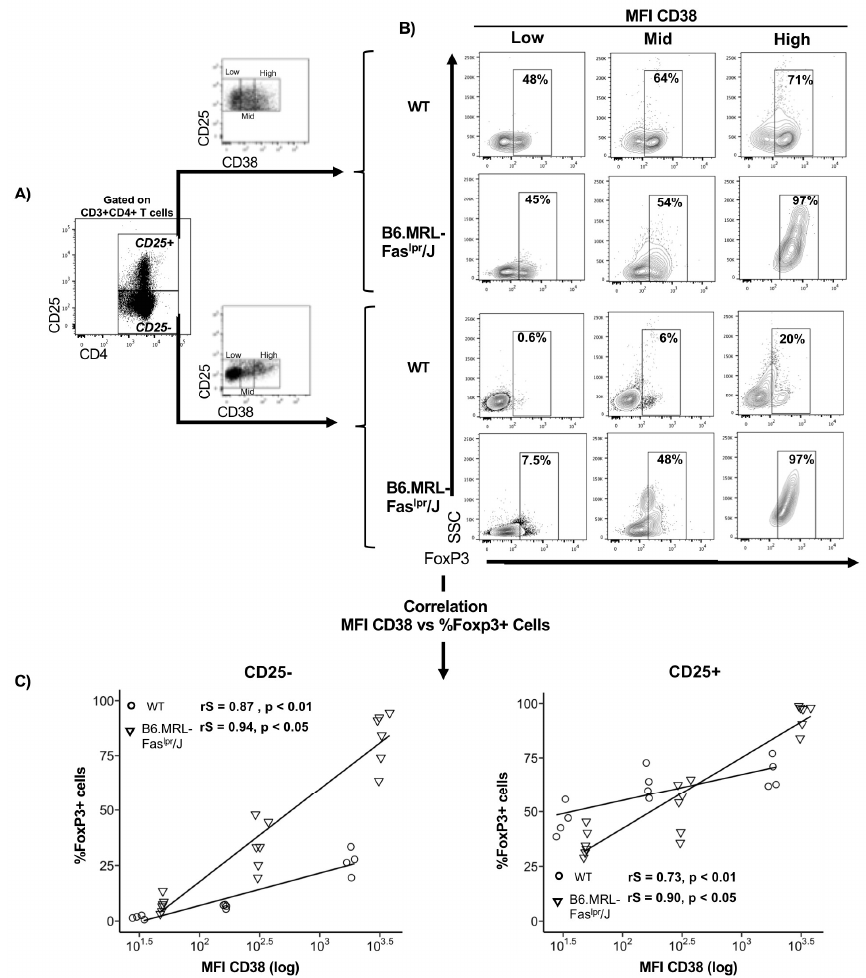
Figure 1. The level of CD38 correlates with FoxP3 frequency in T CD25 + and CD25 − T-cells. Spleno- cytes were stained for cell surface expression of CD3, CD4, CD25, and CD38. The stained cells were fixed and stained intracellularly for FoxP3. ( A ) Splenocytes from wild type (WT) and B6.MRL- Fas lpr /J were gated on CD3 + CD4 + cells and analyzed for CD25 expression. Then, CD3 + CD4 + CD25 + or CD25 − cells were gated on CD38 low , CD38 mid , or CD38 high , according to CD38 expression; ( B ) counter plots showing FoxP3+ cells frequency in CD38 low , CD38 mid , or CD38 high subsets among CD25 + and CD25 − T-cells from WT and B6.MRL-Fas lpr /J; ( C ) correlation plots comparing MFI of CD38 to FoxP3 + cells within either CD4 + CD25 − T-cells (top) or CD4 + CD25 + T-cells (bottom). Symbols represenT-cells from WT ( n = 4) (open symbols) and B6.MRL-Fas lpr /J ( n = 6) (filled symbols). The inset lines are the product of linear regression analysis. Correlations were calculated by the Spearman